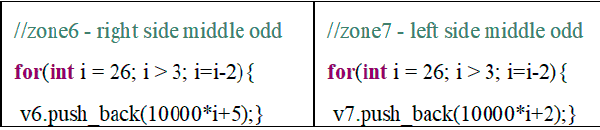
Figure 14. Optimal strategy seat number generation.